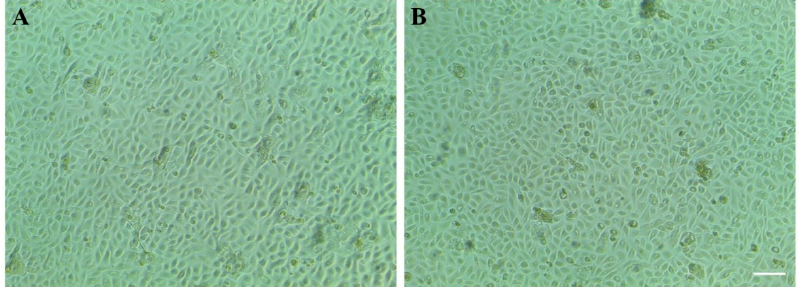
Figure 1. Morphology of hTCEpi cells ( A ) before and ( B ) after AC EF stimulation for 24 h. No significant morphological differences were observed after EF stimulation. Scale bar: 50 μ m.